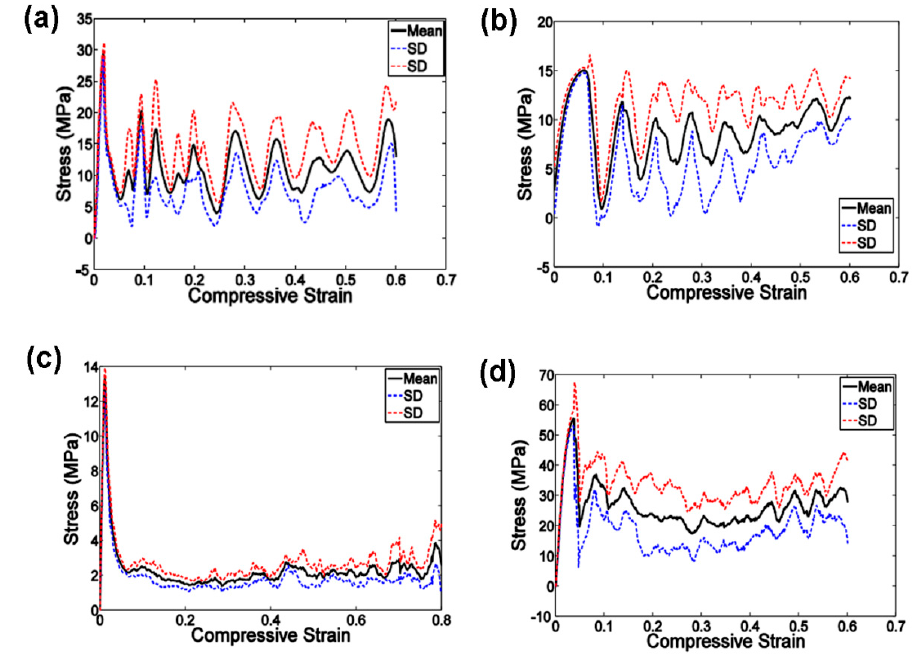
Figure 6. Compressive stress-strain curves of the specimens based on the cube unit cell and with porosity of ( a ) 88%; ( b )78%; ( c ) 74%; ( d ) 66% [39].